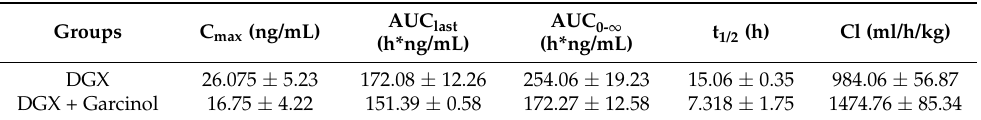
Table 4. Mean ( ± standard deviations) pharmacokinetic parameters of digoxin (DGX) in SD rats with or without oral co-administration of